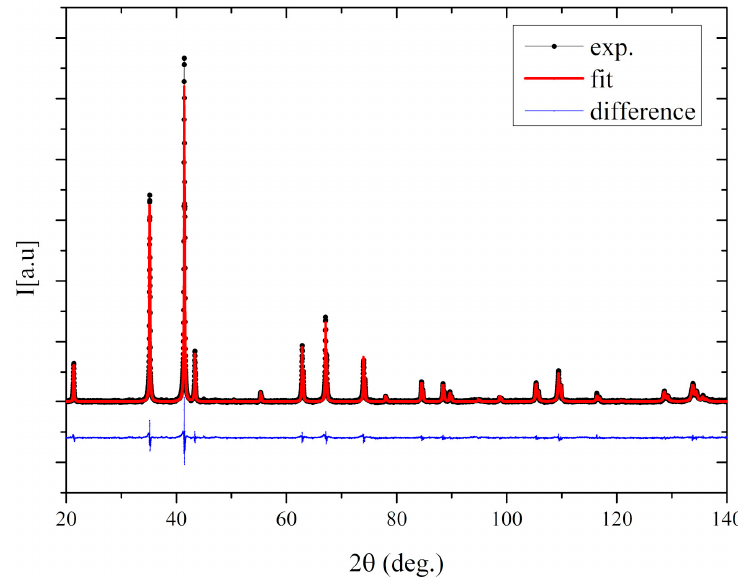
Figure 1. The X-ray diffraction (XRD) patterns for the Gd 0.4 Tb 0.6 Co 2 compound.